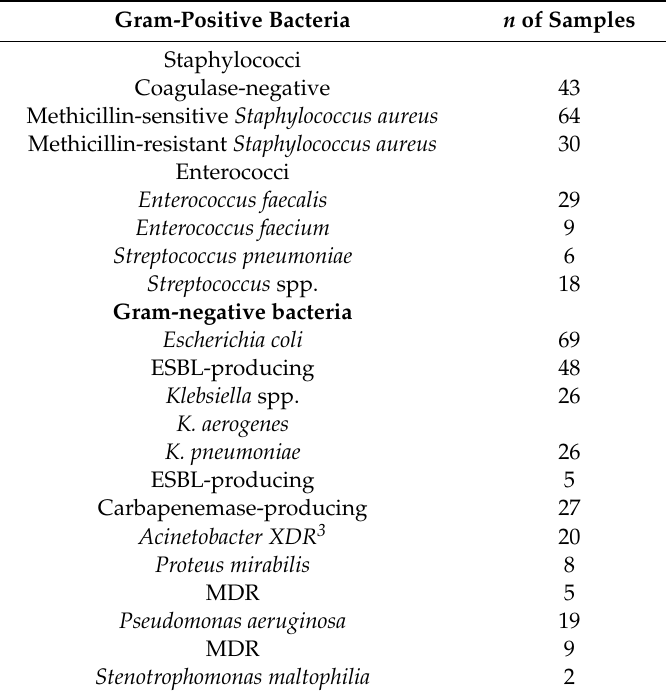
Table 2. BSI etiology in the study